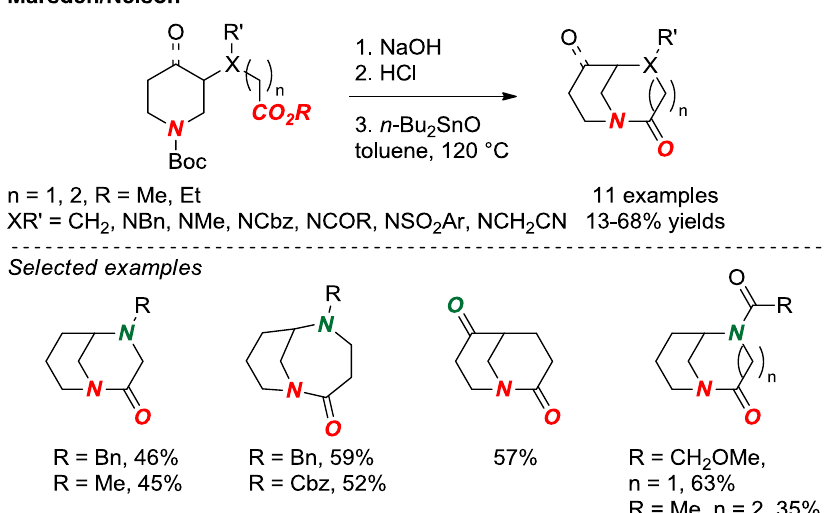
Figure 11. Fragment-Based Drug Discovery using Bridged Lactams.